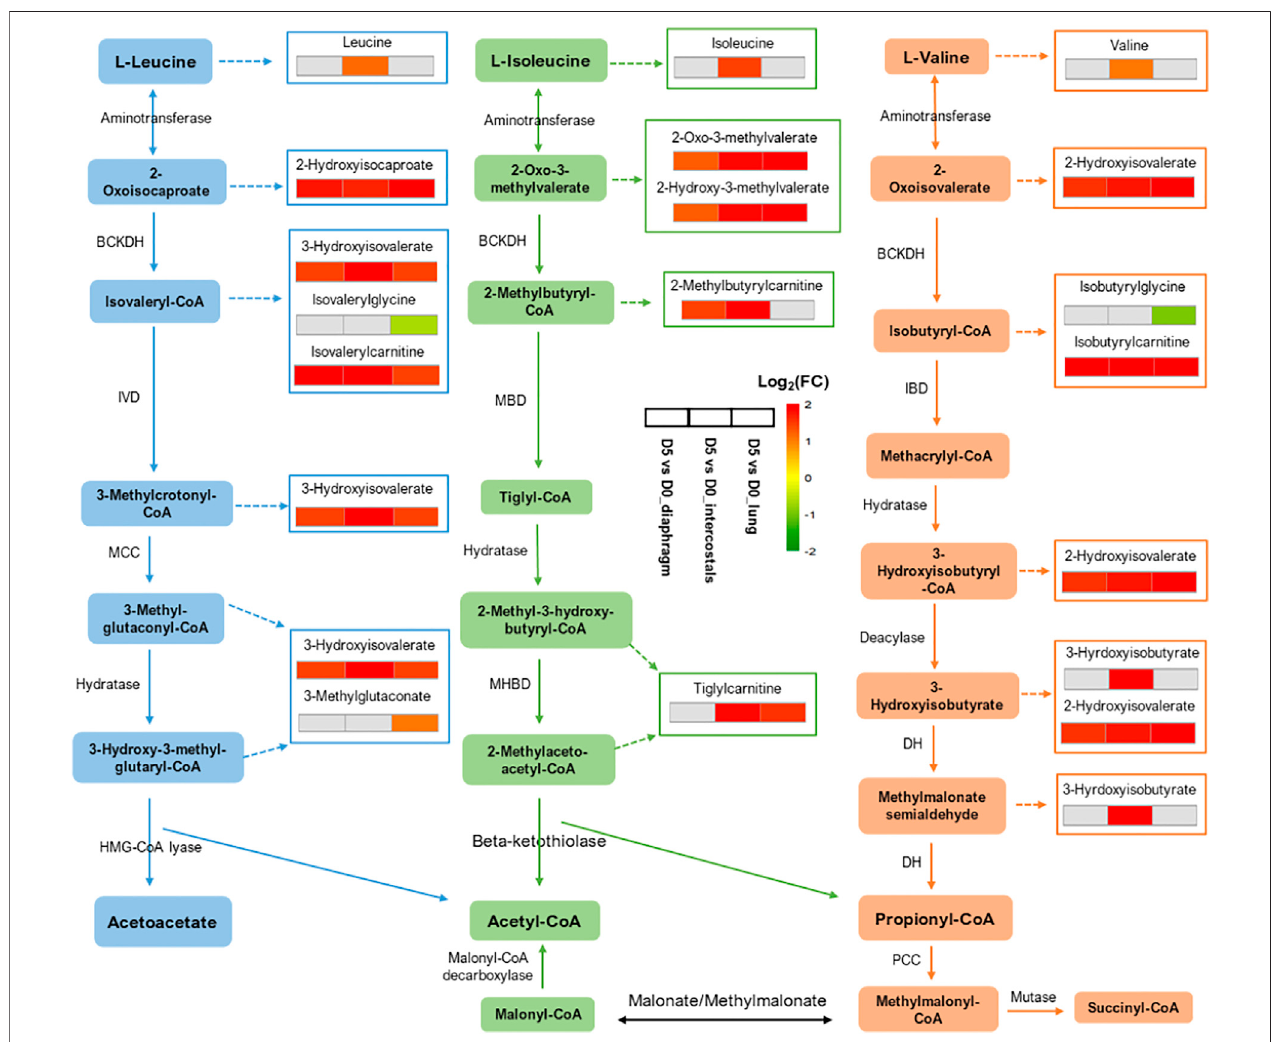
FIGURE 6 | Illustration of “ Leucine, Isoleucine and Valine Metabolism ” and the involved DMs among tissues. Three adjacent blocks represent diaphragm, intercostals, and lung tissue (from left to right). Color scale bar represents Log 2 (FC).